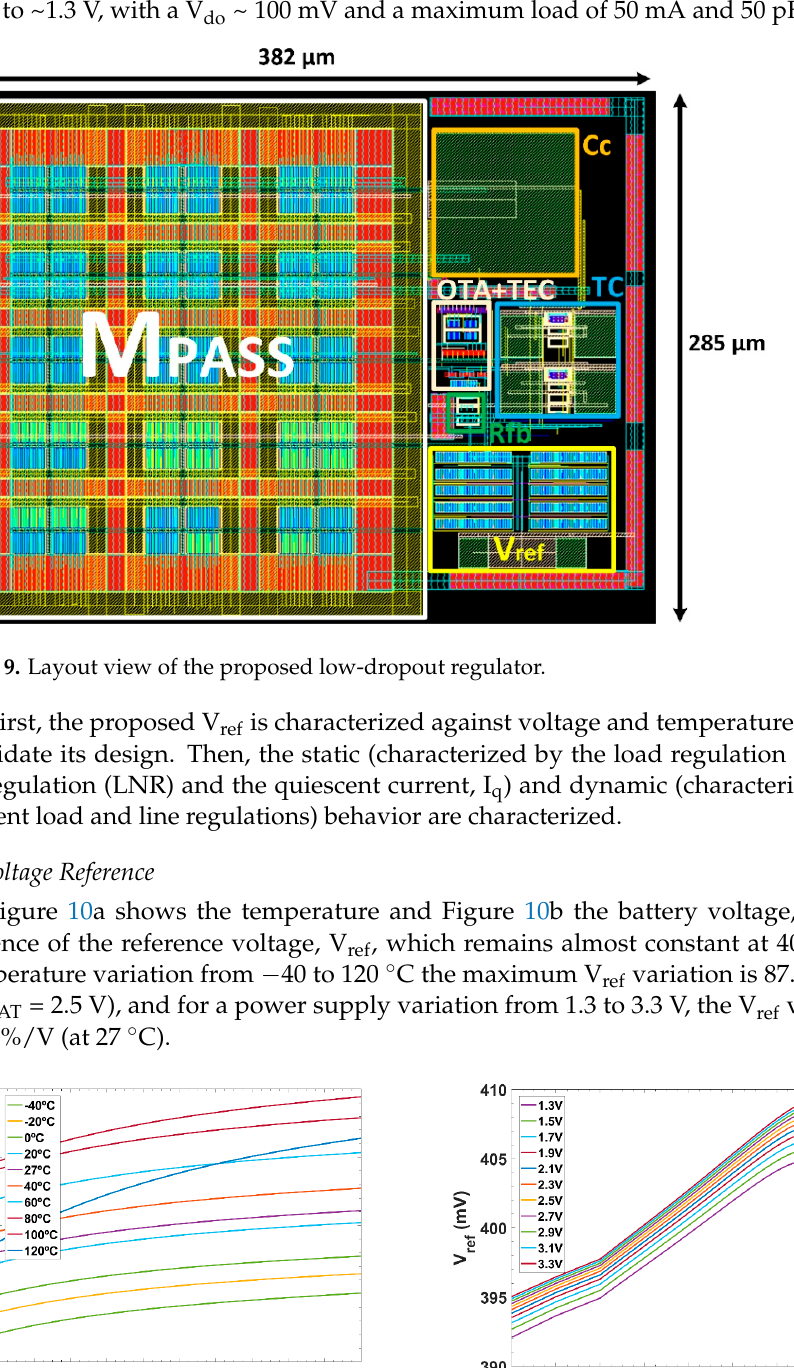
( b ) Figure 11. V in − V out characteristic, with: ( a ) different current loads, I Load , and ( b ) different temperatures (at maximum load current, I Load ).